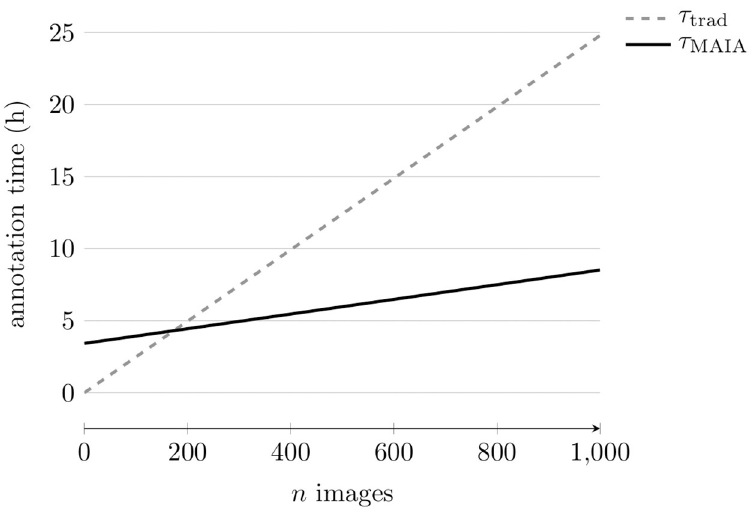
Fig 8. Time it takes to annotate images with a traditional annotation method ( τ trad ) compared to the time it takes using MAIA ( τ MAIA